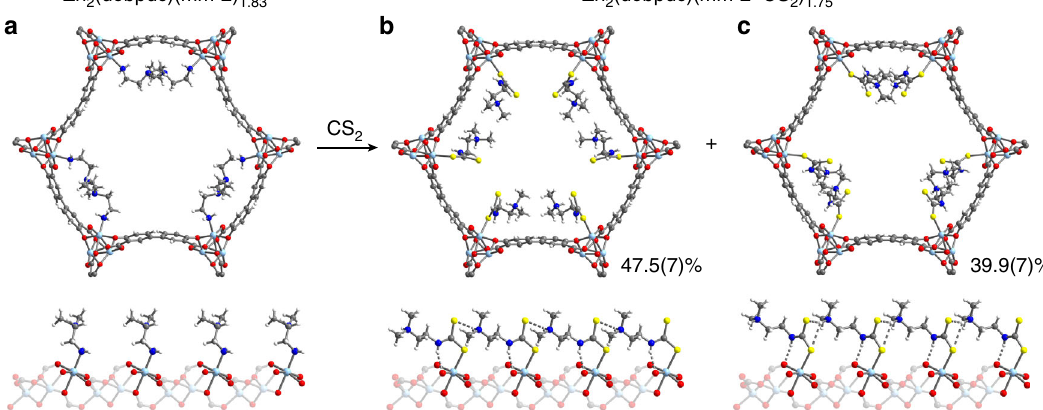
Fig. 4 Single-crystal X-ray diffraction structures. Portions of the mm-2 – Zn 2 (dobpdc) and CS 2 -inserted mm-2 – Zn 2 (dobpdc) structures as viewed perpendicular to the ab plane (top) and along the c axis (bottom). All structures were collected at 100 K and re fi ned as inversion twins in either space group P 3 1 21 or P 3 2 21. For clarity, all images are shown in the P 3 2 21 space group. a The structure of mm-2 – Zn 2 (dobpdc) showing diamines coordinated to the Zn(II) centers. b , c Two coexisting ammonium dithiocarbamate chain conformations observed for CS 2 -inserted mm-2 – Zn 2 (dobpdc). The asymmetric unit consists of a single metal, half of the ligand, and the partial occupancy ammonium dithiocarbamate units in b and c , which branch from the same metal-bound sulfur atom. Apparent overlap of adjacent chains in the ab plane in c implies that neighboring chains exhibit different or alternating conformations, with alternation also possible down the c axis. (Adjacent chains of different conformations do not overlap.) The 10% of Zn(II) sites without dithiocarbamate contain a mixture of solvent, water, CS 2 , or unreacted diamine that could not be modeled. Light blue, blue, red, gray, yellow, and white spheres represent Zn, N, O, C, S, and H atoms,